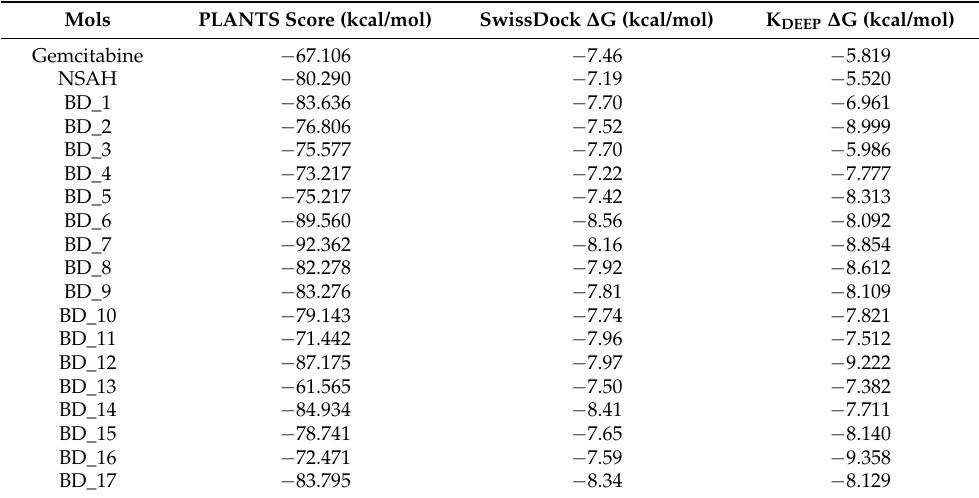
Table 2. PLANTS-based docking score and absolute binding affinity of identified hRRM1 in- hibitors/modulators